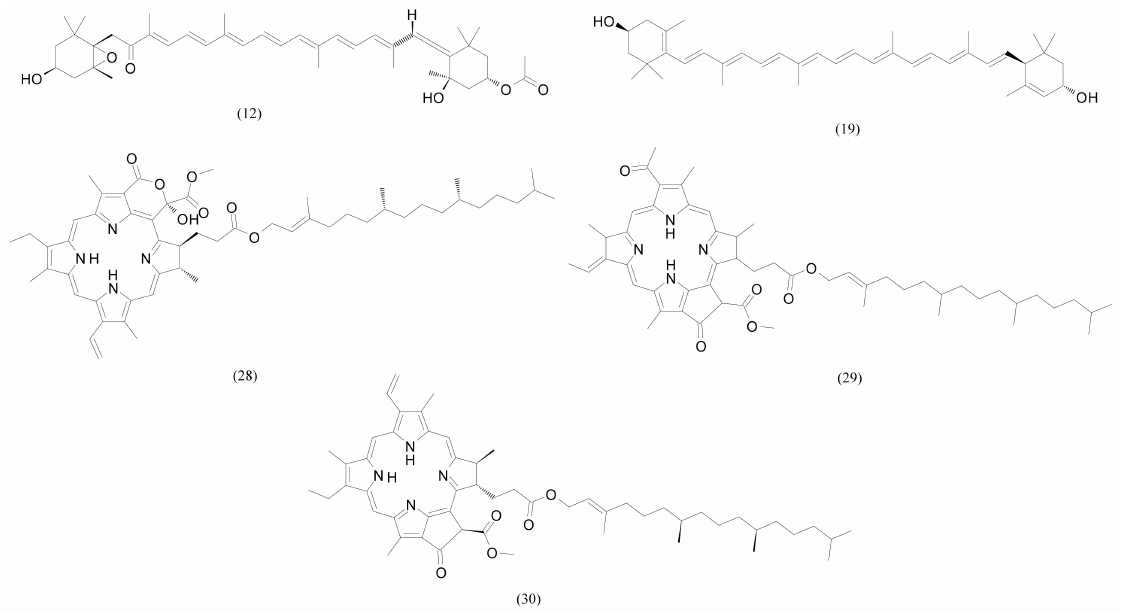
Figure 3. Molecular structures of the major pigments from Table 3, the numbers correspond to Table